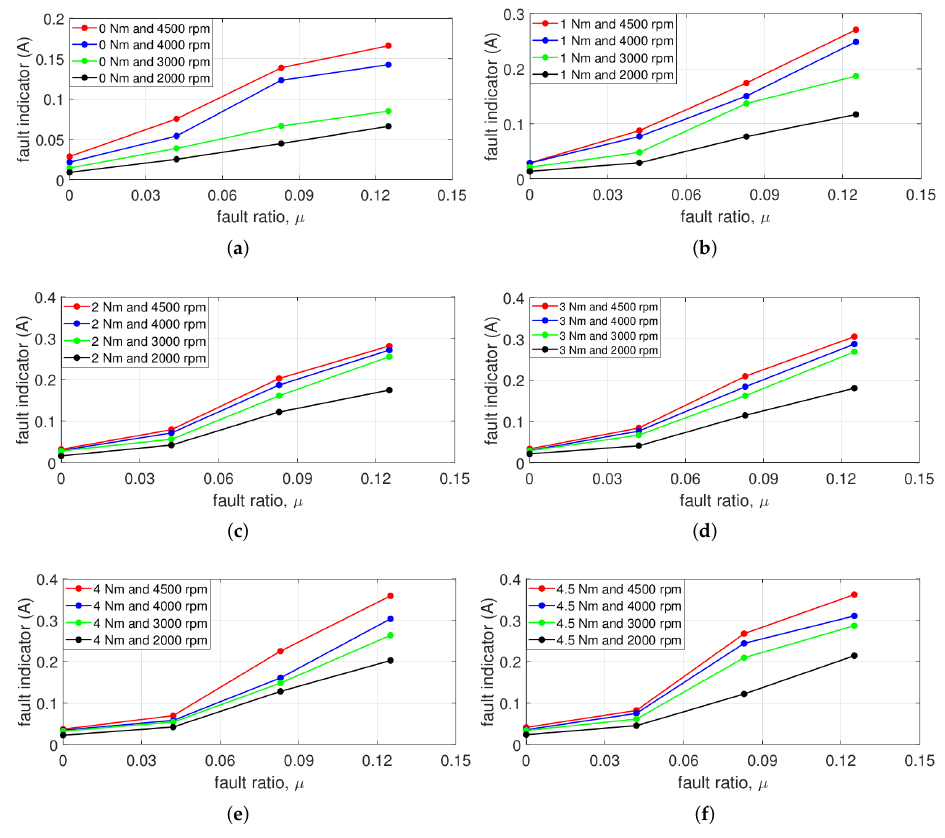
Figure 14. Fault indicator with µ at ( a ) 0, ( b ) 1, ( c ) 2, ( d ) 3, ( e ) 4, and ( f ) 4.5